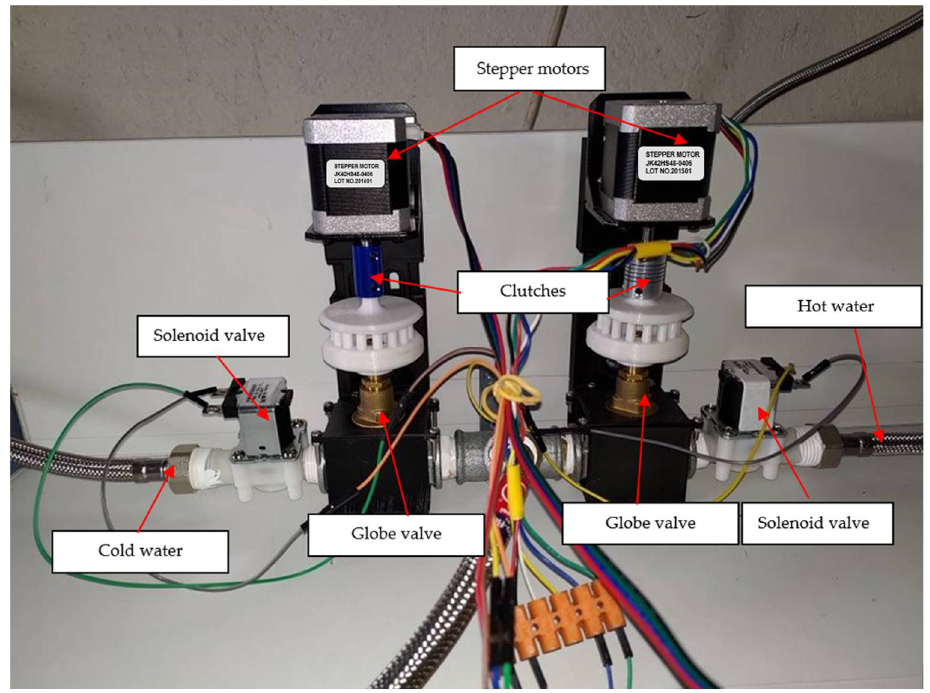
Figure 6. Picture showing stepper motors, globe valves, and solenoid valves.